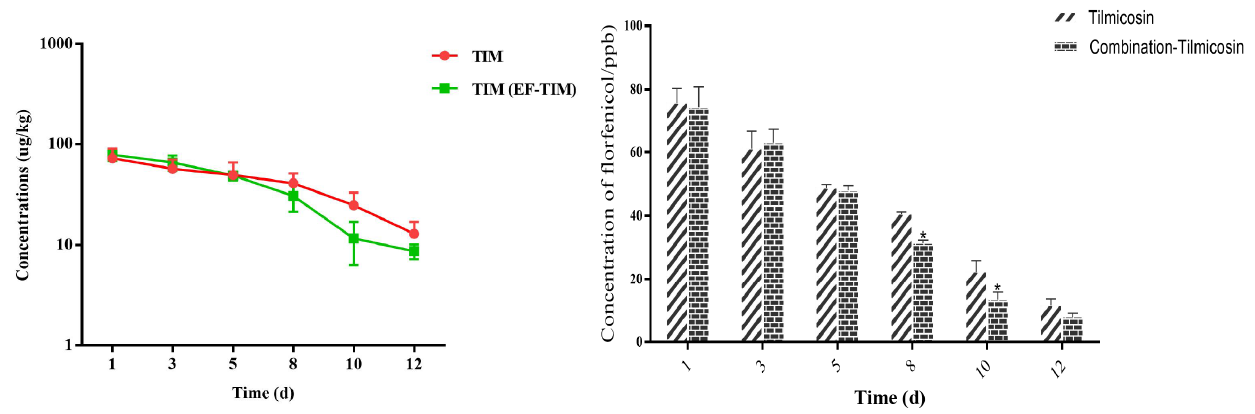
Figure 4. Time-lapse graphs of TIM in eggs. Note: EF (enrofloxacin), TIM (tilmicosin). The data were expressed as mean ± SD. * p < 0.05 denoted statistical significance.